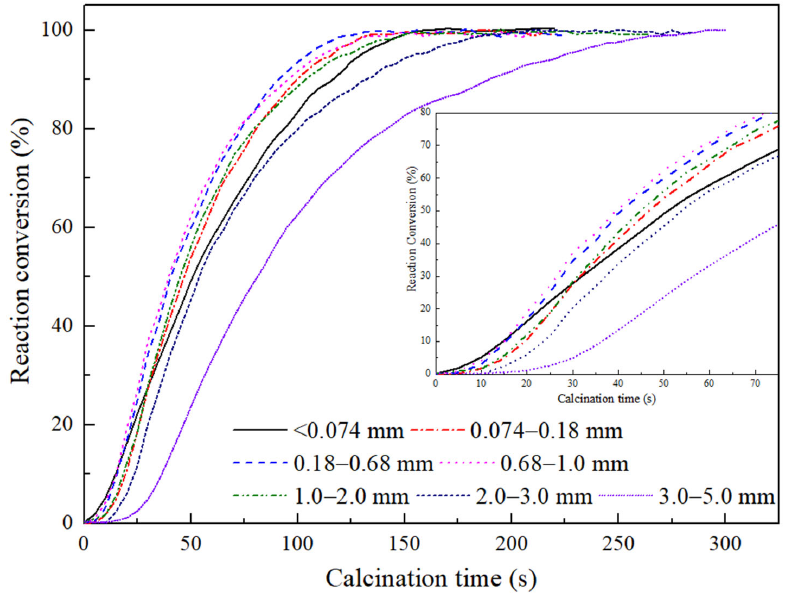
Figure 4. The conversion degree of limestone with different particle sizes with calcination time at 1623 K. at 1623